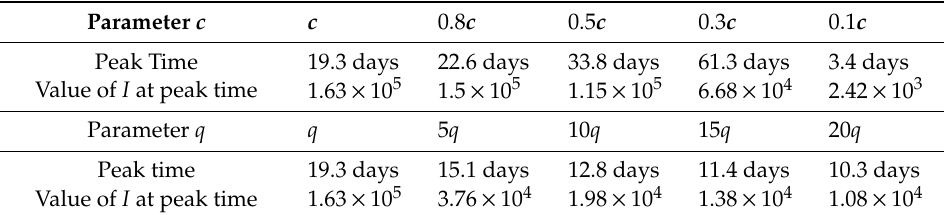
Figure 3. Sensitivity analyses with respect to contact rate, c ( A , B ), and quarantine rate, q ( C , D ), on the log number of infected individuals and cumulative reported cases. Table 3. The e ff ects of travel restrictions on the peak time and peak